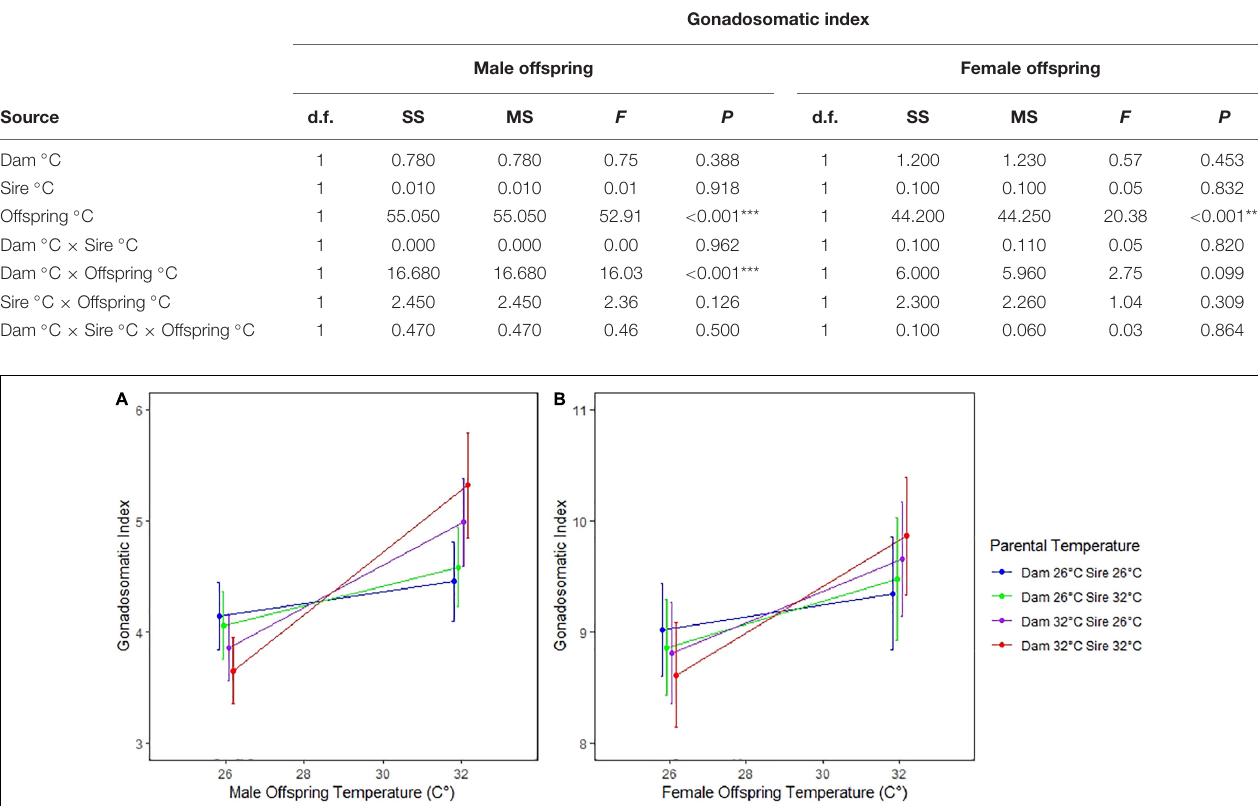
TABLE 3 | ANOVA results for GSI after 30 days of parental temperature exposure and 63 days of offspring growth (Significance codes: “***” 0.001). Gonadosomatic index Male offspring Female offspring